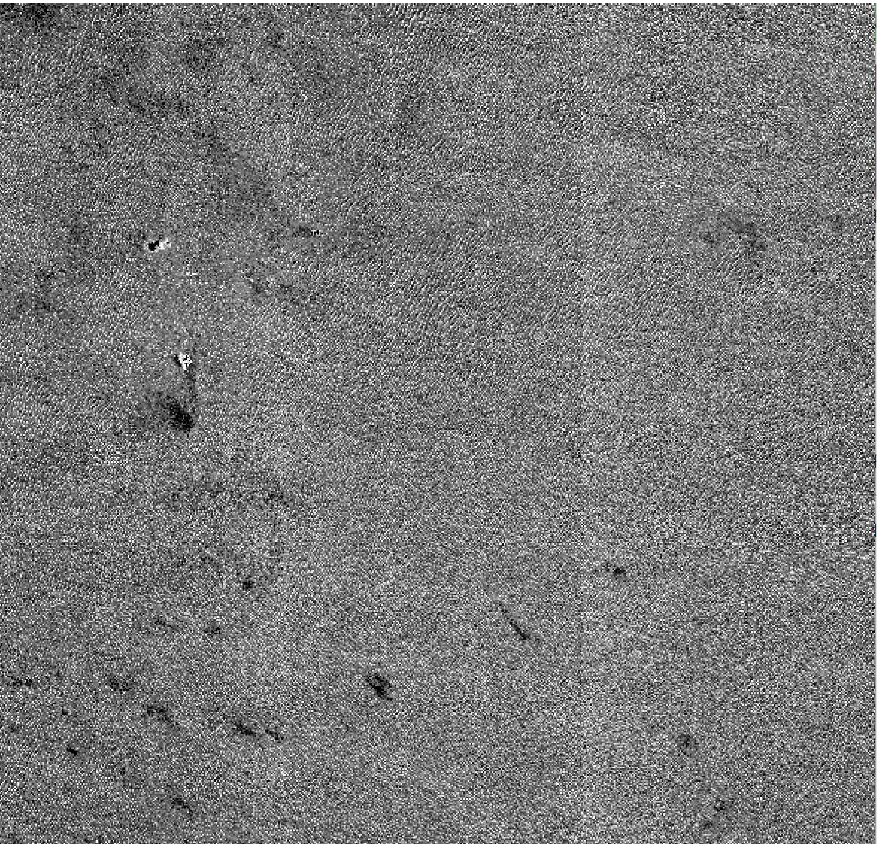
Figure 4. GF-7 BWD-MUX blue band imagery of the uniform Libya 4 PICs (8 August 2020).